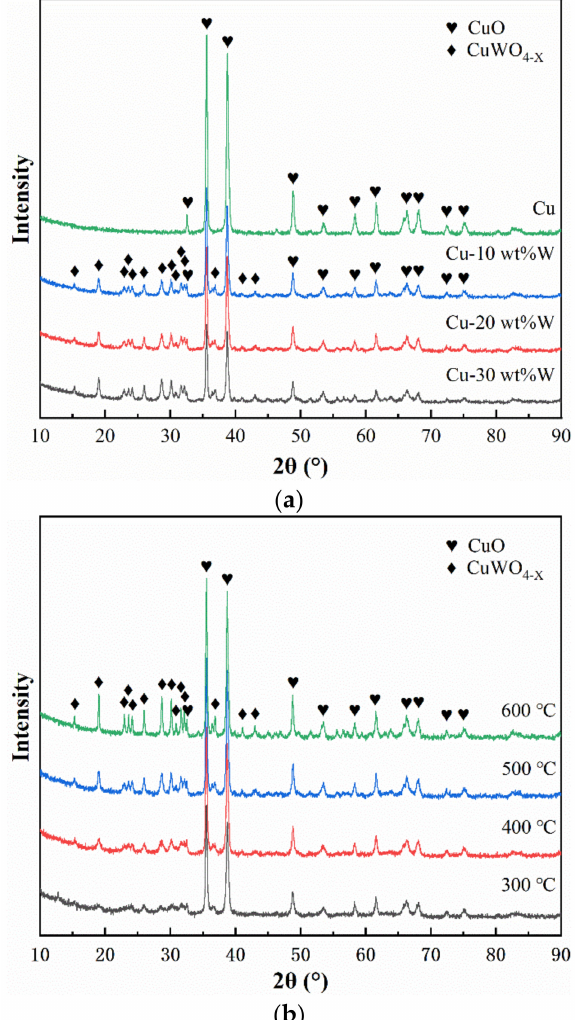
Figure 7. ( a ) XRD patterns of precursor powders with different W content calcined under 500 ◦ C for 2 h; ( b ) XRD patterns of Cu-20 wt%W precursor powders calcined under different temperatures. SEM images of Cu-20 wt%W calcined powders under different temperatures are shown in Figure 9. At 300 ◦ C, the Cu-20 wt%W calcination powder is composed of broken spherical shells and flocculent powders attached to their surface (Figure 9a). When the calcination temperature rises to 400 ◦ C, the broken spherical shells are transformed into lumpy powders formed by the agglomeration of flattened lamellar particles, and the flocculent powders increase (Figure 9b). Zhu et al. [28] pointed out that, under mild reaction conditions, the aggregation trend of CuO particles may be caused by the low nucleation rate and growth rate of CuO particles. When calcined at 500 ◦ C, the flocculent powders are transformed into fine agglomerated nano-spherical particles and connect dispersed micron-sized flat flake CuO into